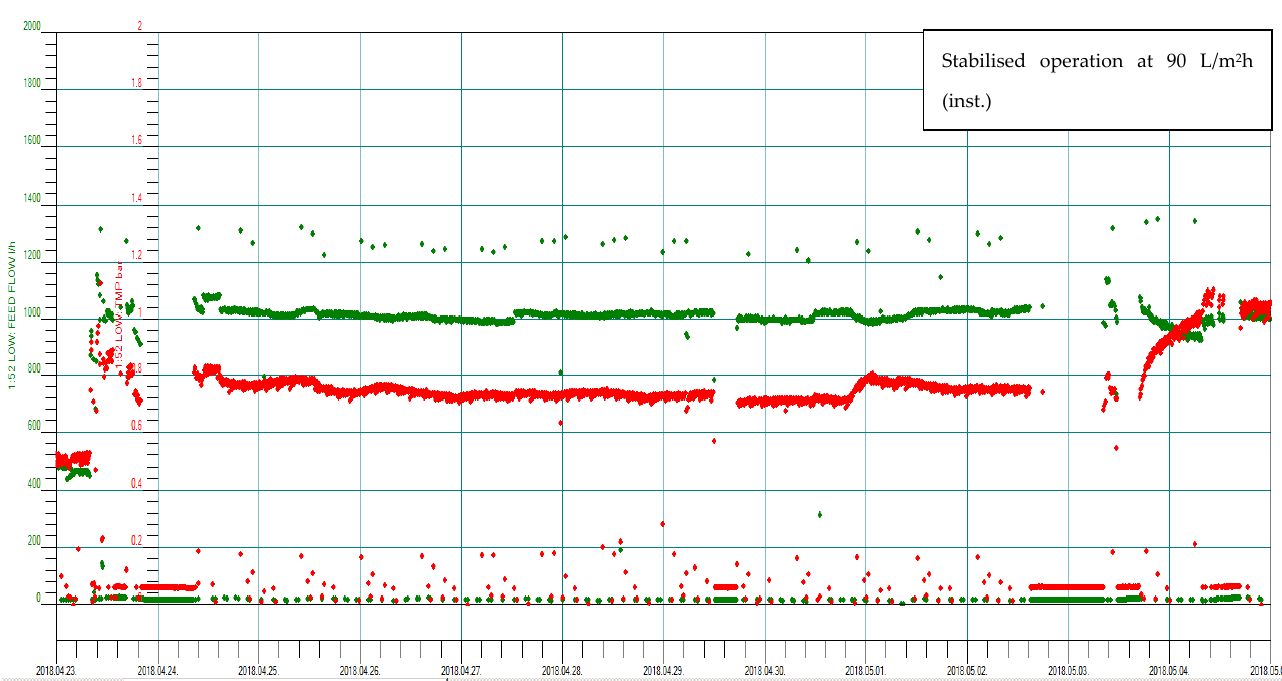
Figure A6. Flow and TMP.